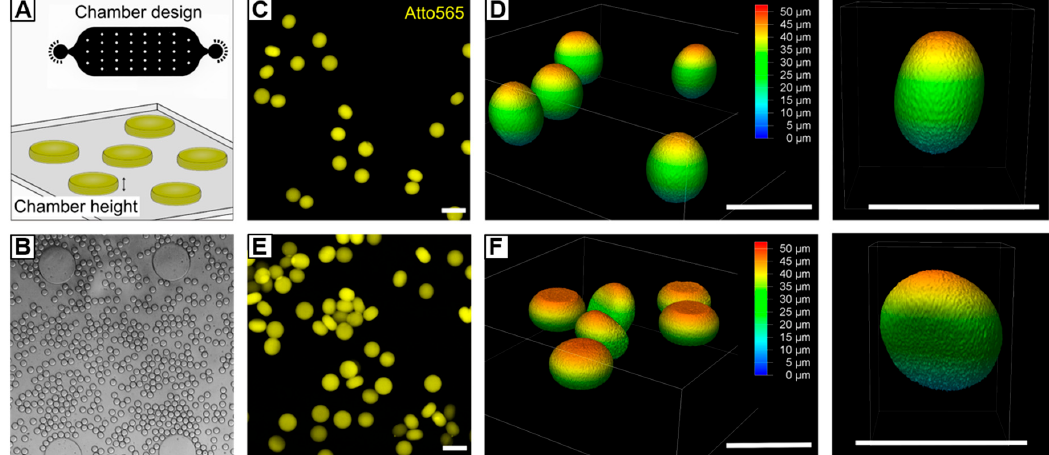
Figure 8. Microfluidic fabrication of non-spherical HASH − 0.75 microgels. ( A ) By transferring HASH − 0.75 W/O emulsion into a chamber with a height of 20 µm, droplets are compressed into non-spherical shape while being exposed to UV light. Depending on selected flow rates and droplet dimensions, respectively, microgels of different architectures can be generated. ( B ) Exemplary brightfield microscopy image of squeezed droplets flowing through the on-chip UV-chamber. ( C – F ) Confocal microscopy images and corresponding z-stacks of (C) and (D) egg-shaped microgels with an aspect ratio of 1.2 and (E, F) disk-like microgels with an aspect ratio of 1.5. All scale bars denote 50 µm.